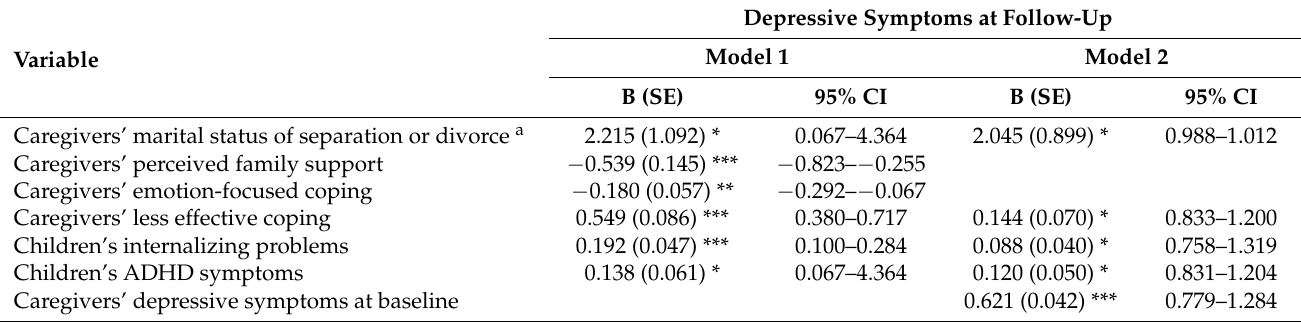
Table 3. Predictors of depressive symptoms at follow-up: multivariate regression